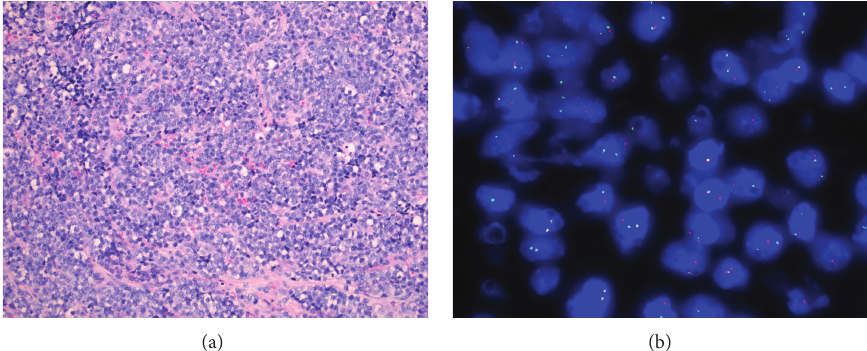
Figure 3: (a) Microphotograph of intraneural Ewing’s sarcoma showing sheets of monotonous small round cells (10x magnification; H&E stain). (b) FISH study of the intraneural Ewing’s sarcoma. The split red dots indicate a rearrangement of the EWS